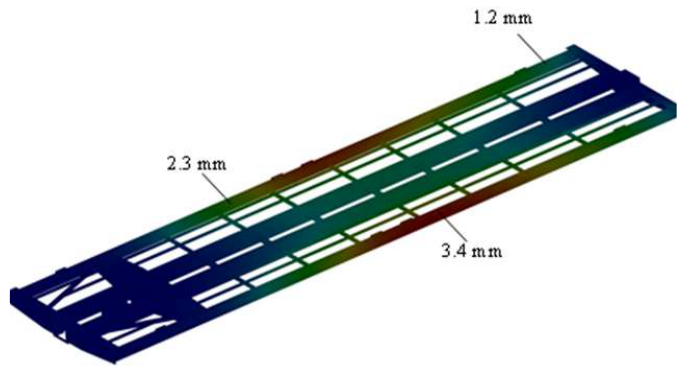
Figure 12. Displacements in nodes of the articulated flat wagon section. Table 2. Basic strength parameters of the carrying structures of articulated circular-tube